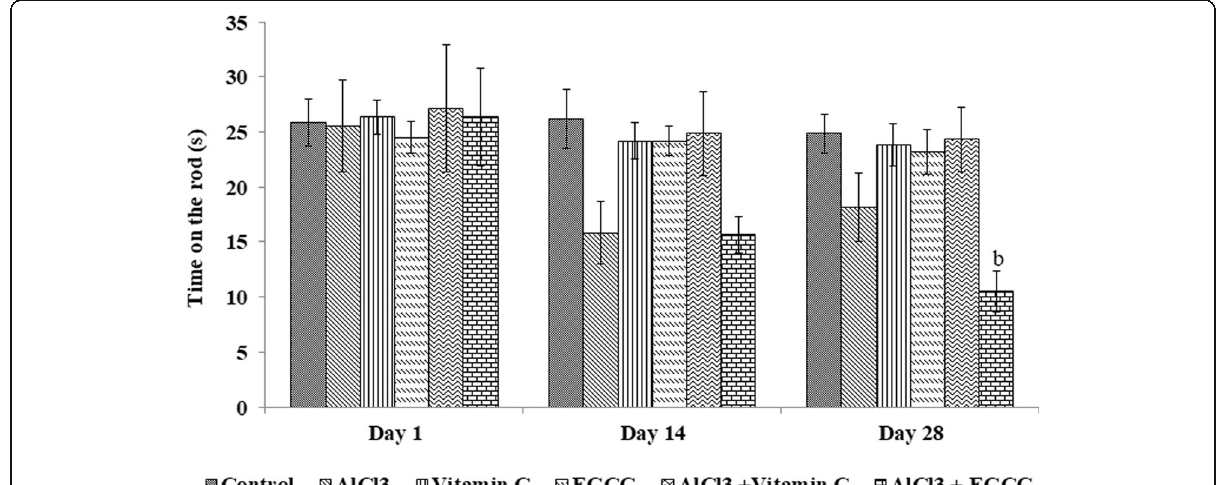
Fig. 5 Effect of EGCG on muscular coordination of the rats. Values are expressed as mean ± SEM ( n = 6). b P < 0.05 compared with control (one- way ANOVA followed by Tukey ’ s post-hoc